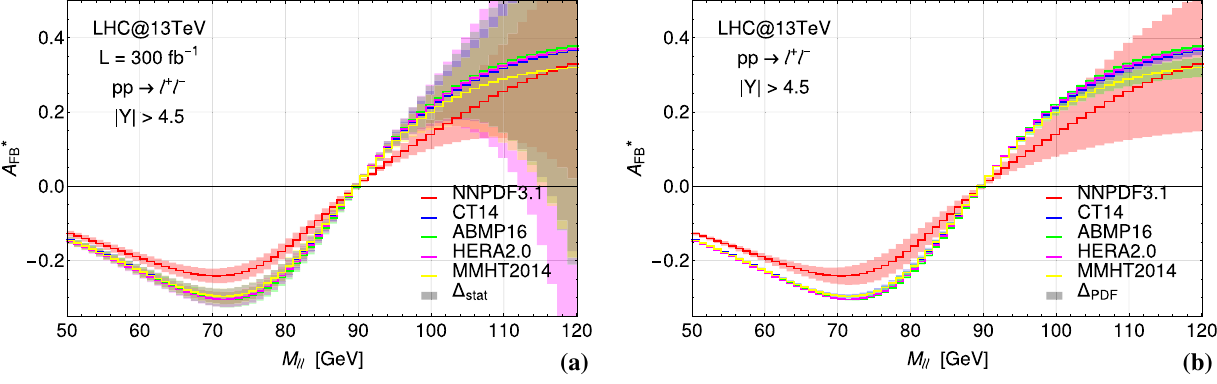
Fig. 6 A ∗ as a function of the di-lepton invariant mass including the a statistical and b PDF errors with a rapidity cut | y | > 4 . 5. A luminosity FB L = 300 fb − 1 is assumed and acceptance cuts | η | < 5 and p T > 20 GeV are imposed on both